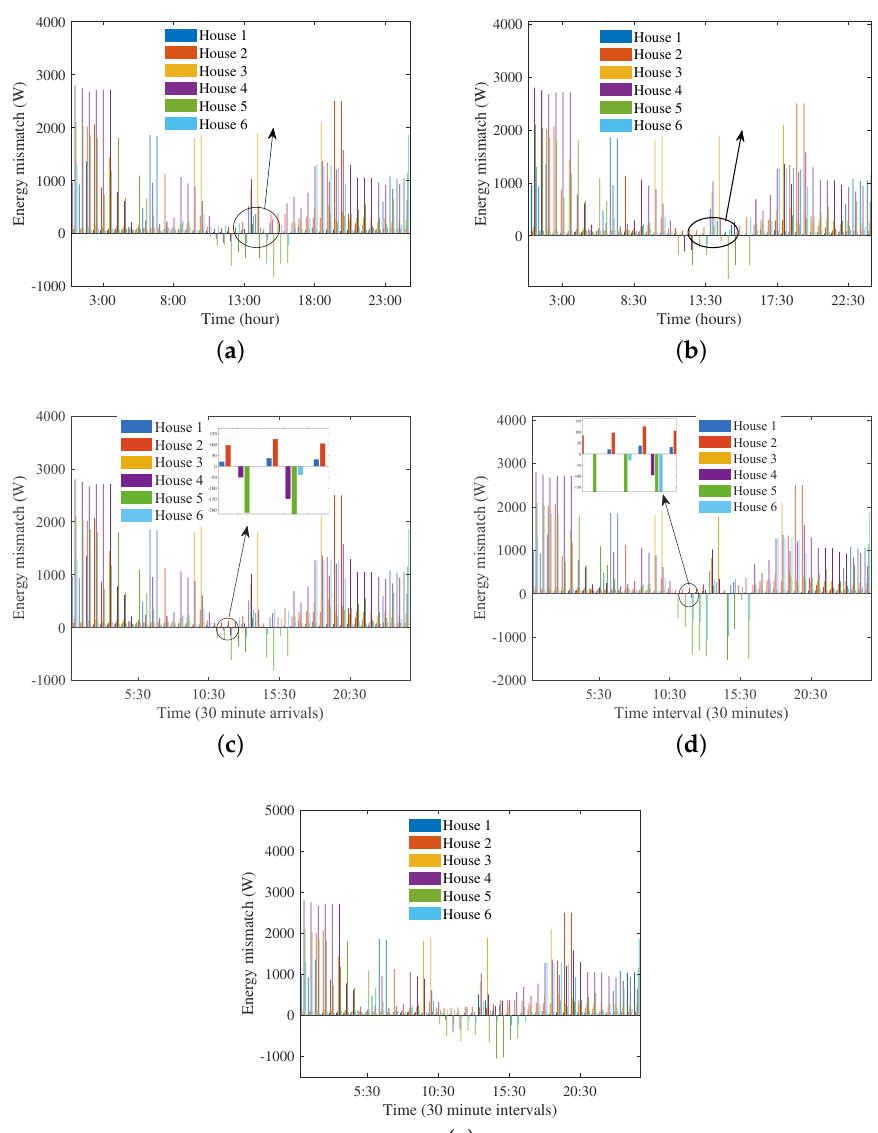
Figure 4. Energy mismatch at the 6 houses in the microgrid before and after energy trading considering different priorities. ( a ) After stage 1, zoomed section indicates the energy mismatch at house 2 during 12:30–3:00 p.m.; ( b ) After stage 2, zoomed section indicates the energy mismatch at house 2